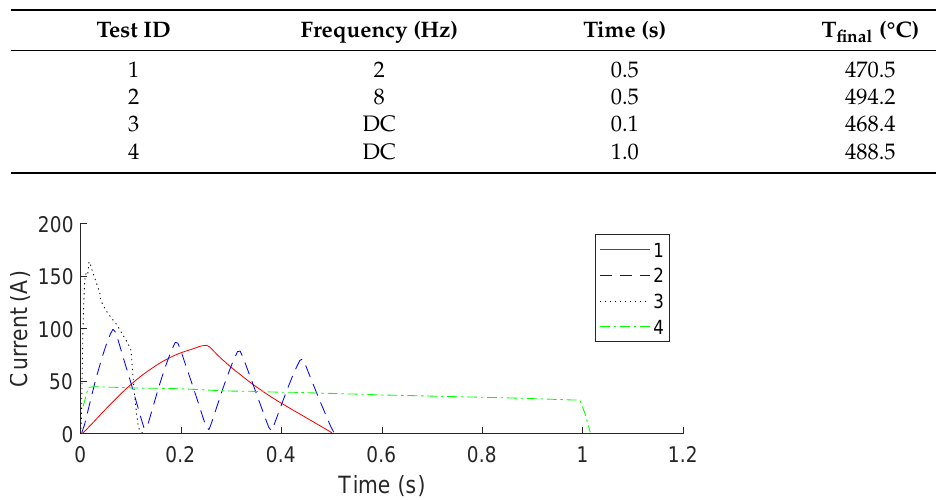
Table 2. Example tests used for thermal analyses.